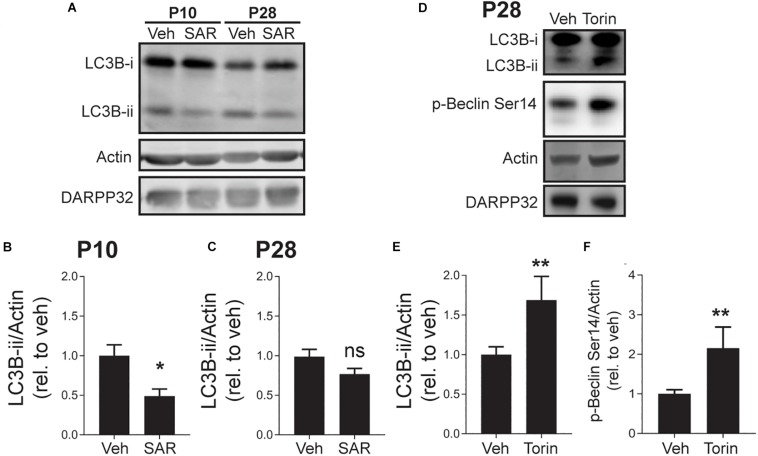
Vps34 activity is required for maintaining LC3B-ii levels at P10 and mTOR inhibition increases p-Beclin-1 and LC3B-ii levels at P28. (A) Representative Western blot images for actin, DARPP32 and LC3B-i and -ii in striatal slices obtained from P10 or P28 mice, treated with SAR405 (1 μM) or vehicle (Veh; DMSO, 0.1%). (B,C) Quantification of LC3B-ii relative to actin, normalized to vehicle condition at each age. (B) P10: unpaired, two-tailed t-test, t11 = 2.985, p = 0.0124; P28: unpaired, two-tailed t-test, t24 = 1.807, p = 0.0922. P10: Veh: n = 6 slices, SAR405 n = 7 slices from 3 to 4 mice/age. (C) P28: Veh: n = 9 slices, Baf n = 7 slices from 3 to 4 mice/age. *p < 0.05. (D) Representative Western blot images for actin, DARPP32, p-Beclin-1 Ser14 and LC3B-i and -ii in striatal slices from P28 mice, treated with Torin-1 (5 μM) or vehicle (Veh; DMSO, 0.1%). Quantification of (E) LC3B-ii and (F) p-Beclin S14 relative to actin, normalized to vehicle. Data analyzed with unpaired, two-tailed t-test; (E) LC3B-ii/actin, t24 = 2.853, p = 0.0088. Veh: n = 19 slices, Baf n = 7 slices from 5 to 7 mice. *p < 0.05. (F) p-Beclin S14/actin, t22 = 3.337, p = 0.0030. **p < 0.01, Veh: n = 18 slices, Torin-1 n = 6 slices from 3 to 5 mice.